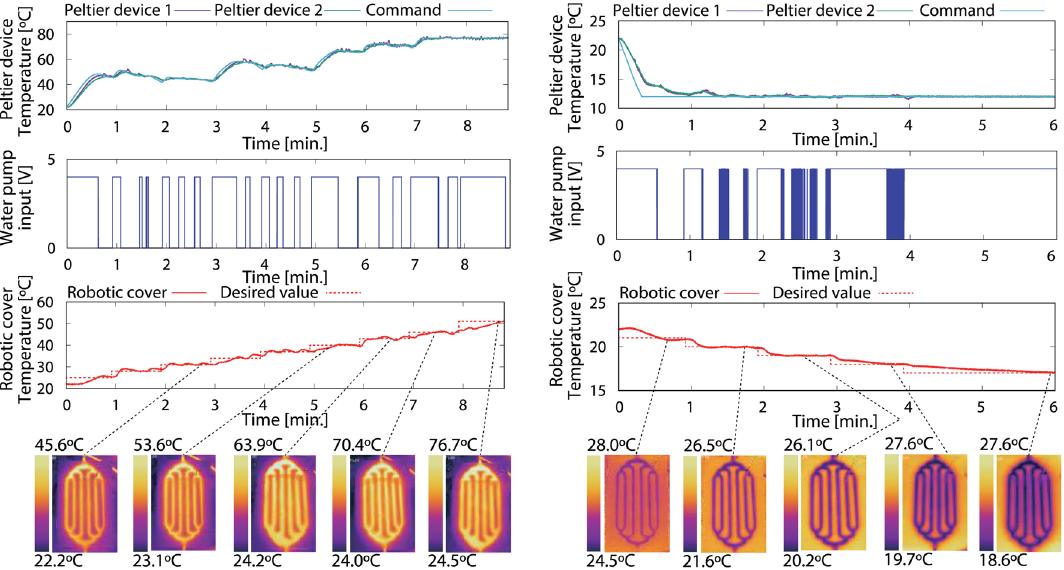
Figure 6. The cover temperature is controlled with successively increasing or decreasing step temperatures. The responses of Peltier device’s temperature, water pump’s voltage input, and temperature of the cover surface are monitored. The cover temperature is heated by 3 °C (5 °C in the end) until 51 °C (left figure) and cooled by 1 °C until 17 °C (right figure), keeping each temperature command for 60 s. Each response speed is less than 10 s after completely heating/cooling the circulating